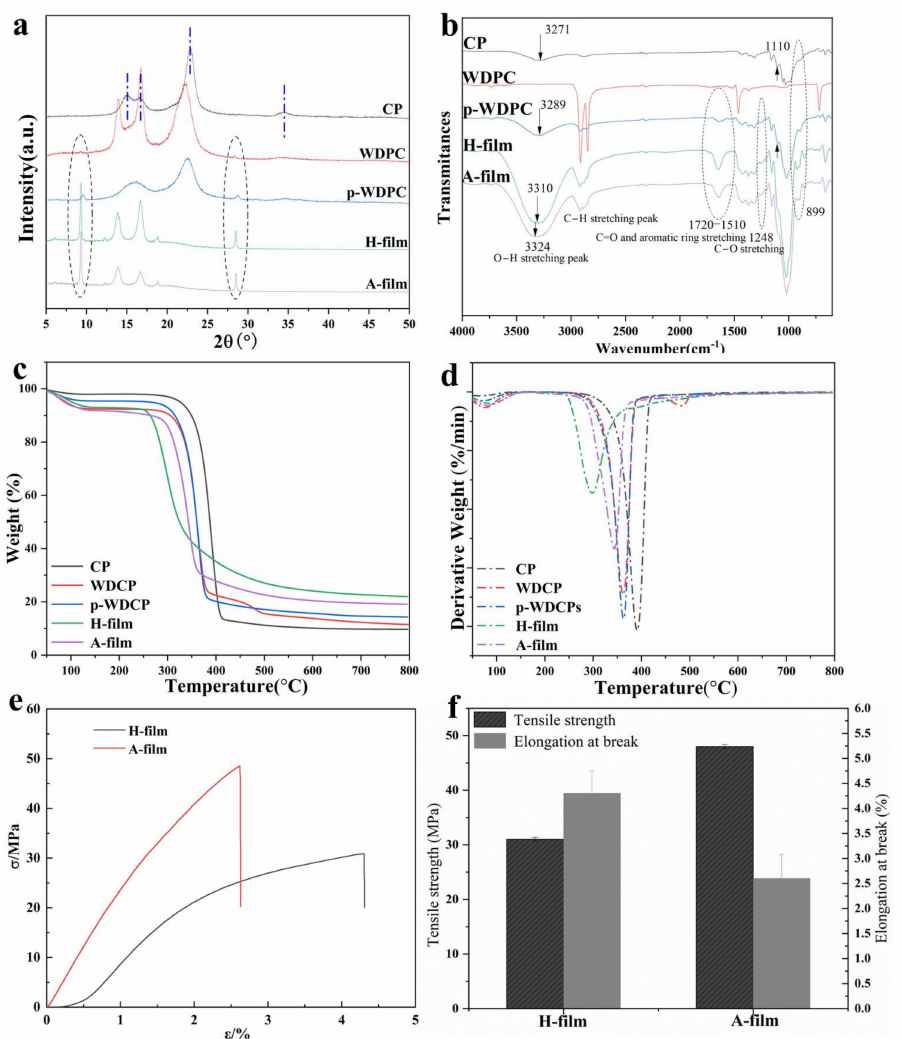
Figure 5. ( a ) XRD, ( b ) FTIR curves, ( c ) TG and ( d ) DTG of CP, WDPC, p-WDPC, H-film and A-film; Stress-strain curves ( e ), tensile strength and elongation at break ( f ) of the H-film and